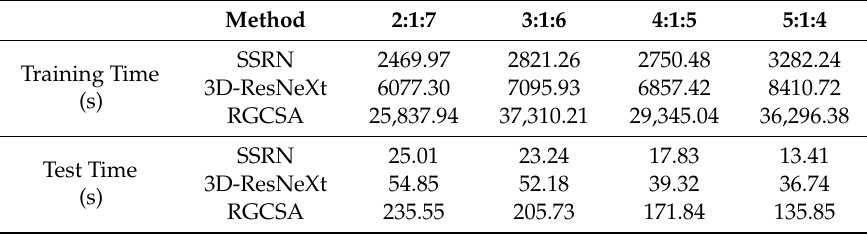
Table 16. Training time and test time for di ff erent networks in the UP dataset.